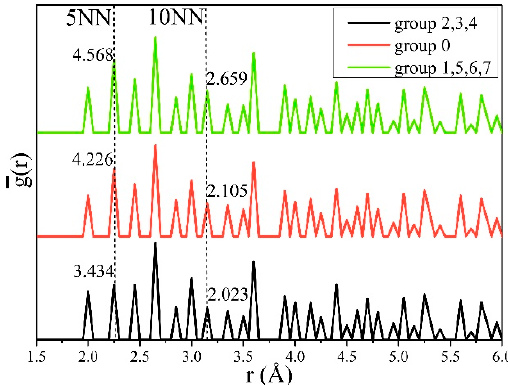
Figure 5. The averaged partial pair-correlation function (PCF) g ( r ) for structures in clustered groups. ∆ E dis and ∆ G dis increased with the hydrogen atoms distributed in the 5th nearest neighbor (5NN) and 10th nearest neighbor (10NN) sites.